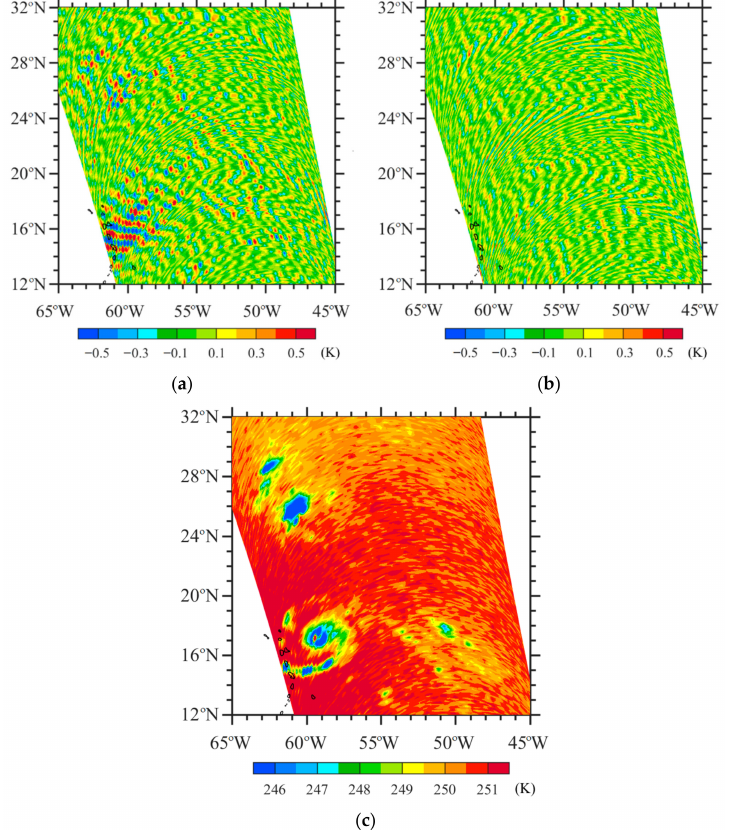
Figure 9. ( a ) Channel 3 noise at the ascending node on 5 September 2017 extracted by the same method as channel 5. ( b ) Same as ( a ) except for adding a step to avoid the impact of heavy precipitation- induced TB outliers of abnormally small value on noise mitigation. ( c ) The reconstructed channel 3 TB